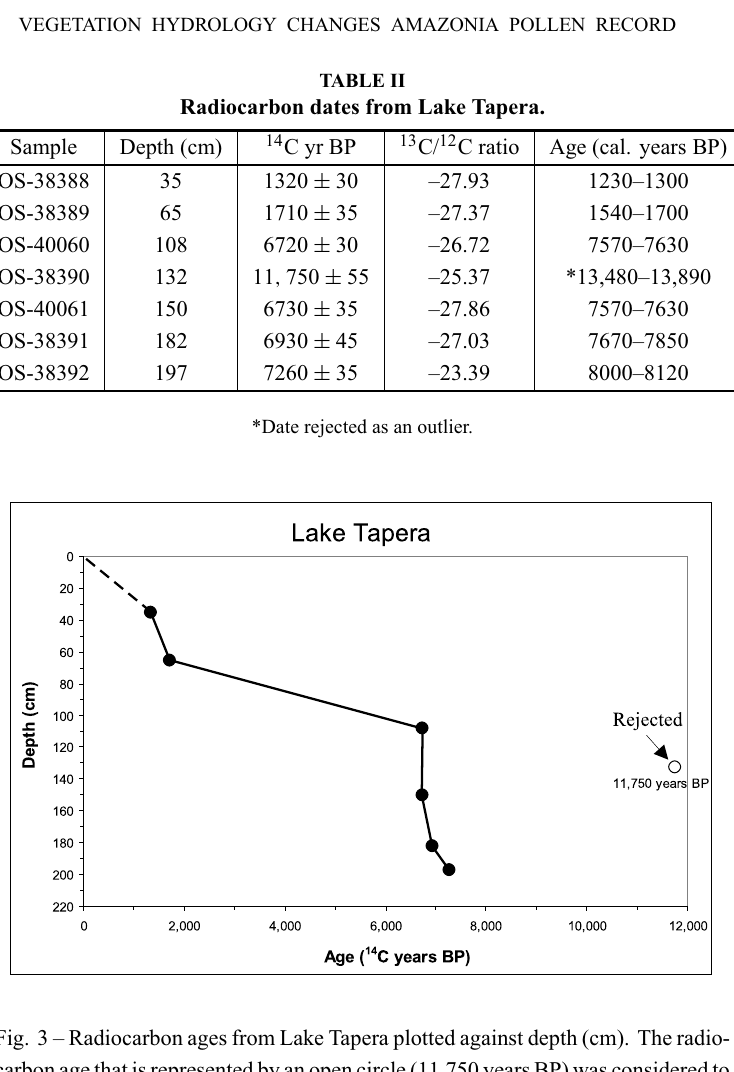
Fig. 3 – Radiocarbon ages from Lake Tapera plotted against depth (cm). The radio- carbon age that is represented by an open circle (11,750 years BP) was considered to be a contamination, and therefore rejected as an outlier. The dashed lines represent the extrapolated ages towards the